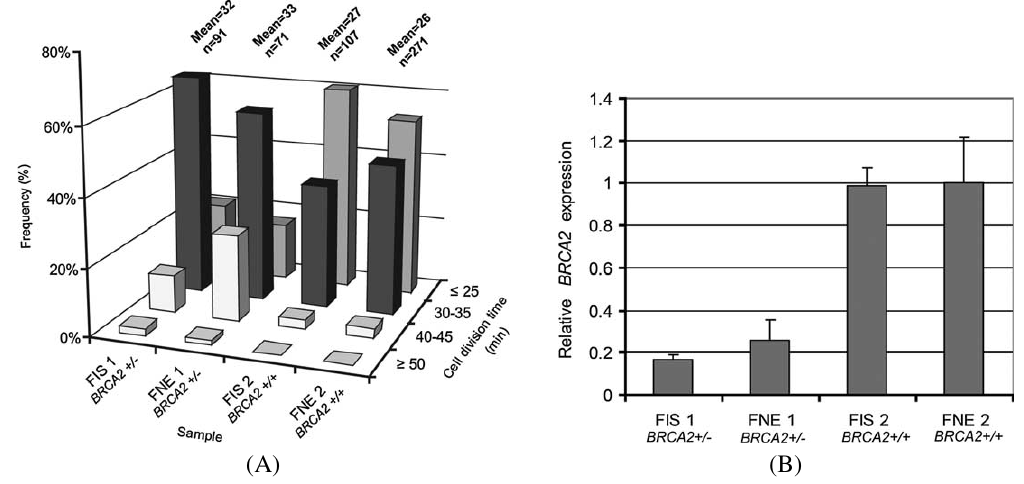
Fig. 2. Frequency distribution of the cell division time and BRCA2 mRNA expression levlels of BRCA2 + / − and BRCA2 + / + unmodified primary human fibroblasts. (A) Cell division time was estimated from images obtained by time lapse live-cell imaging as shown in Fig. 1. The two BRCA2 + / − samples, FIS 1 and FNE 1, show the same phenotype, delayed cytokinesis, but different from the two BRCA2 + / + samples, FIS 2 and FNE 2. 50–60% of the BRCA2 + / + cells completed cell division within 25 min and for 35–45% the process took about 30–35 min and less than 5% had a delayed cytokinesis of 40–45 min. Up to 20% of the BRCA2 heterozygous mutant cells finished the process within 25 min but for the majority cytokinesis took 30–35 min. For about 20% of the BRCA2 + / − cells cytokinesis proceeded for 40 min or longer with maximum cell division time of 65 min. No cell failed to divide. (B) BRCA2 mRNA expression levels were quantified with qRT-PCR. The two BRCA2 + / − samples, FIS 1 and FNE 1, show on average 5 times lower BRCA2 expression than the two BRCA2 + / + samples, FIS 2 and FNE 2, 0.167 and 0.254 versus 0.987 and 1.00, respectively. The difference between the BRCA2 + / − and the BRCA2 + / + samples was shown to be significant ( p = 0 . 03).